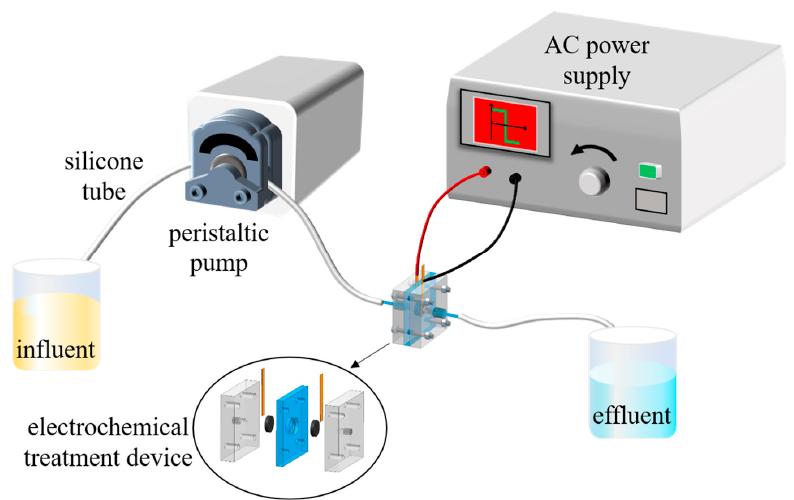
Figure 1. Flow ‐ through electric treatment device based on the asymmetric alternating current sys ‐